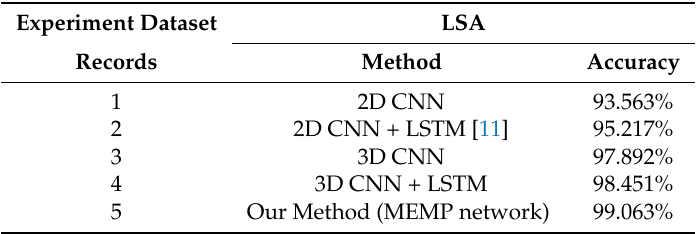
Table 4. LSA experimental